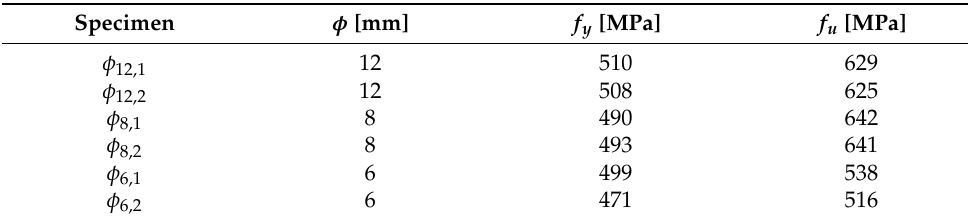
Figure 1. Stress–strain curves measured from material testing of two samples of each reinforce- ment diameter. Table 2. Summary of results from tensile testing of the reinforcement used.